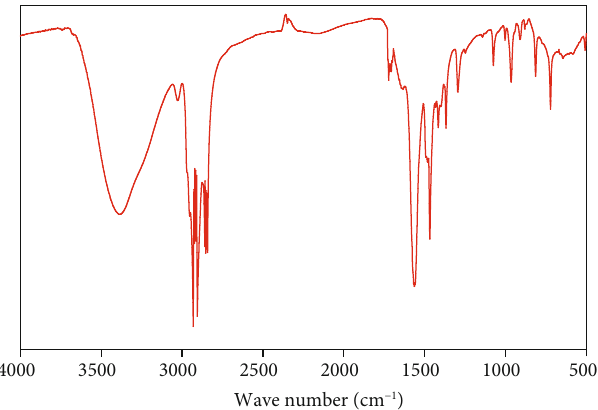
Figure 1: FT-IR spectrum of